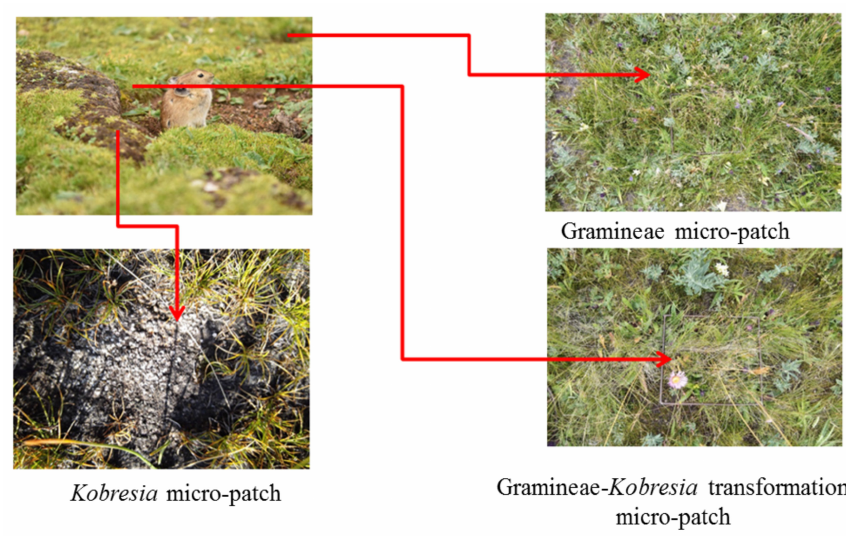
Figure 2. Typical micro-patches seen in the research